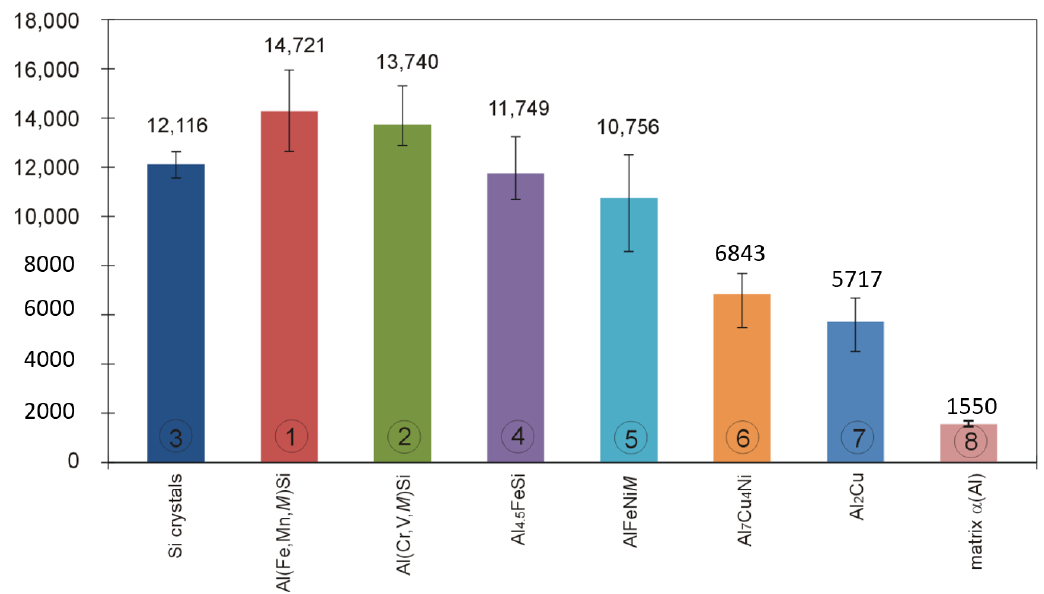
Figure 15. Values of indentation hardness H IT for primary silicon crystals, intermetallic phase crystals, and matrix of hypereutectic silumin determined with the use of indentation technique.